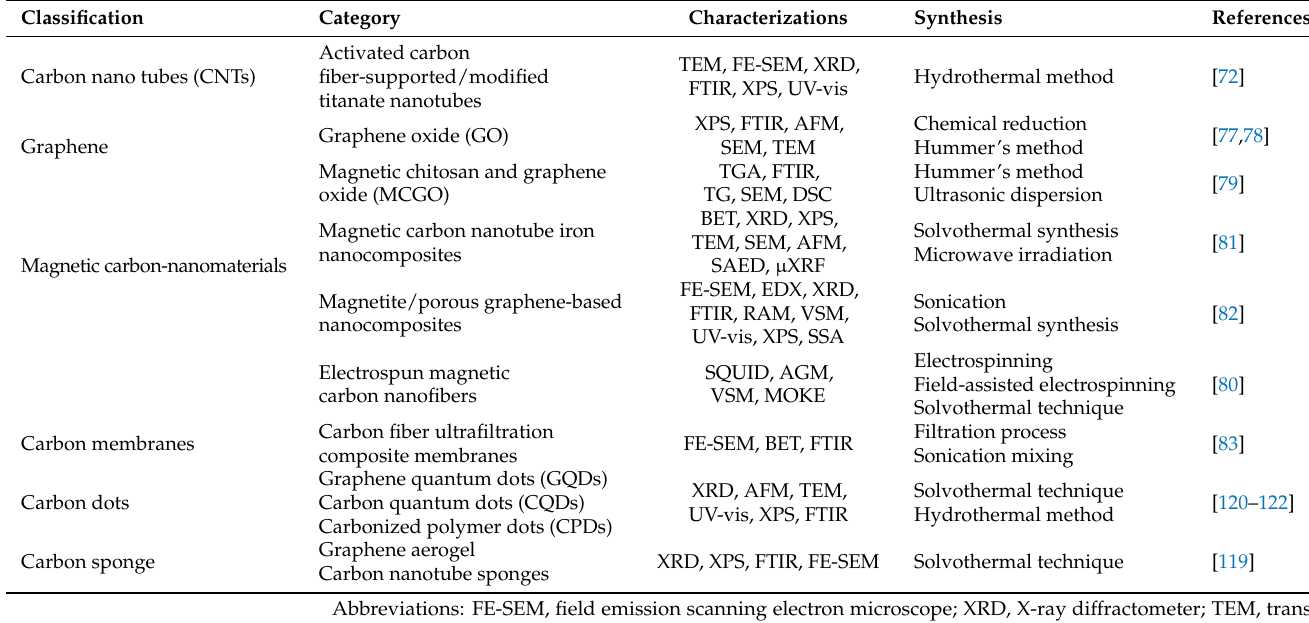
Table 3. Synthesis and characterization of some carbon